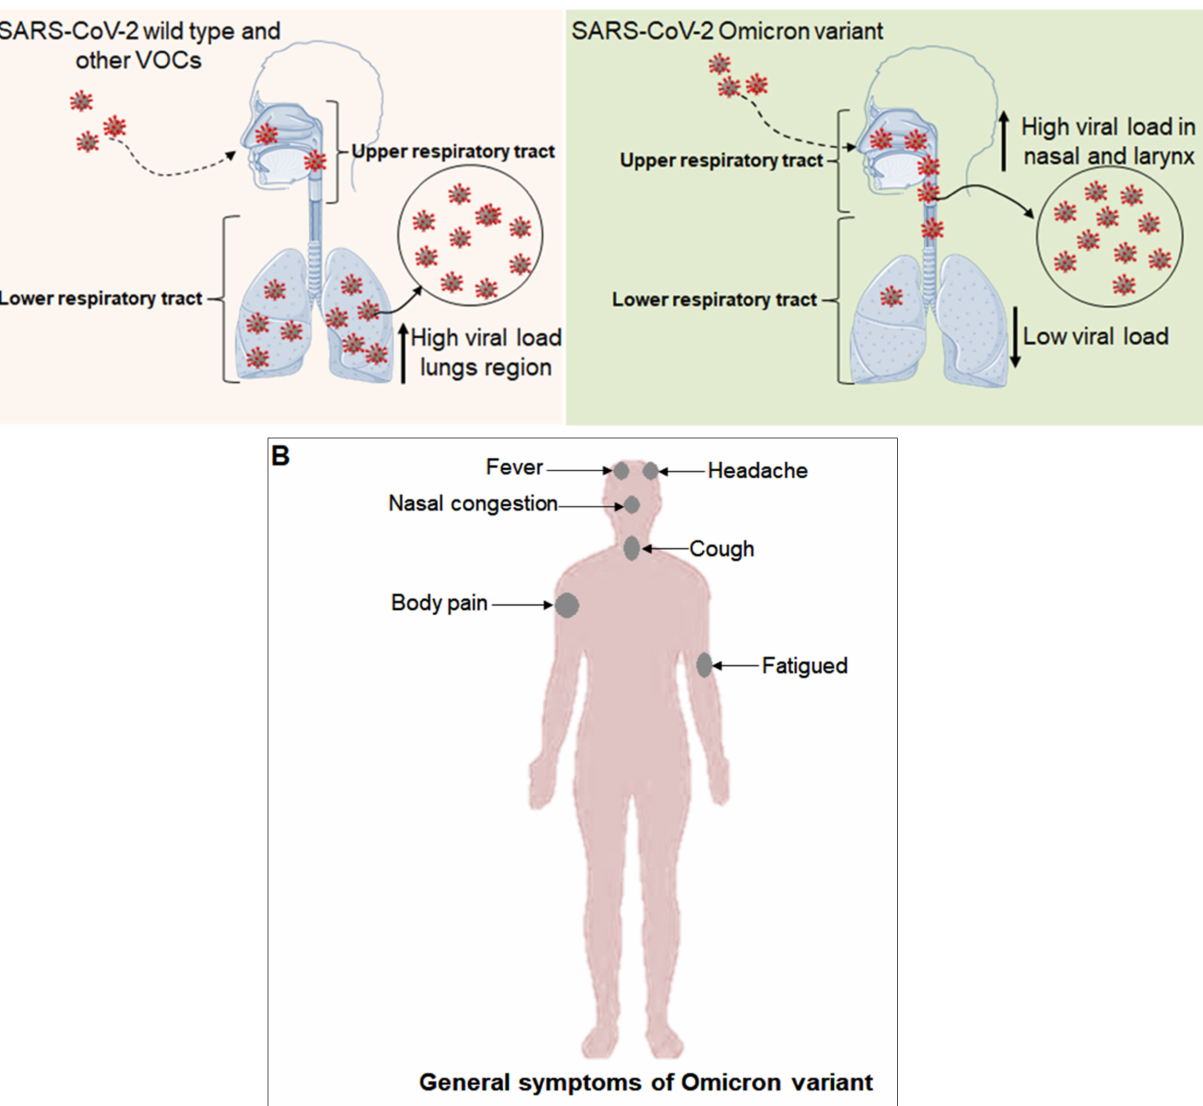
Figure 5. The figure shows viral load in the respiratory tract and the lungs during an infection with the wild strain of SARS-CoV-2 and Omicron. The figure also describes the common symptoms of Omicron-infected patients. ( A ) It shows high viral load in the respiratory tract during Omicron infection. It shows high viral load in lungs during an infection with the wild strain of SARS-CoV-2. ( B ) The figure depicting the common clinical symptoms of Omicron-infected